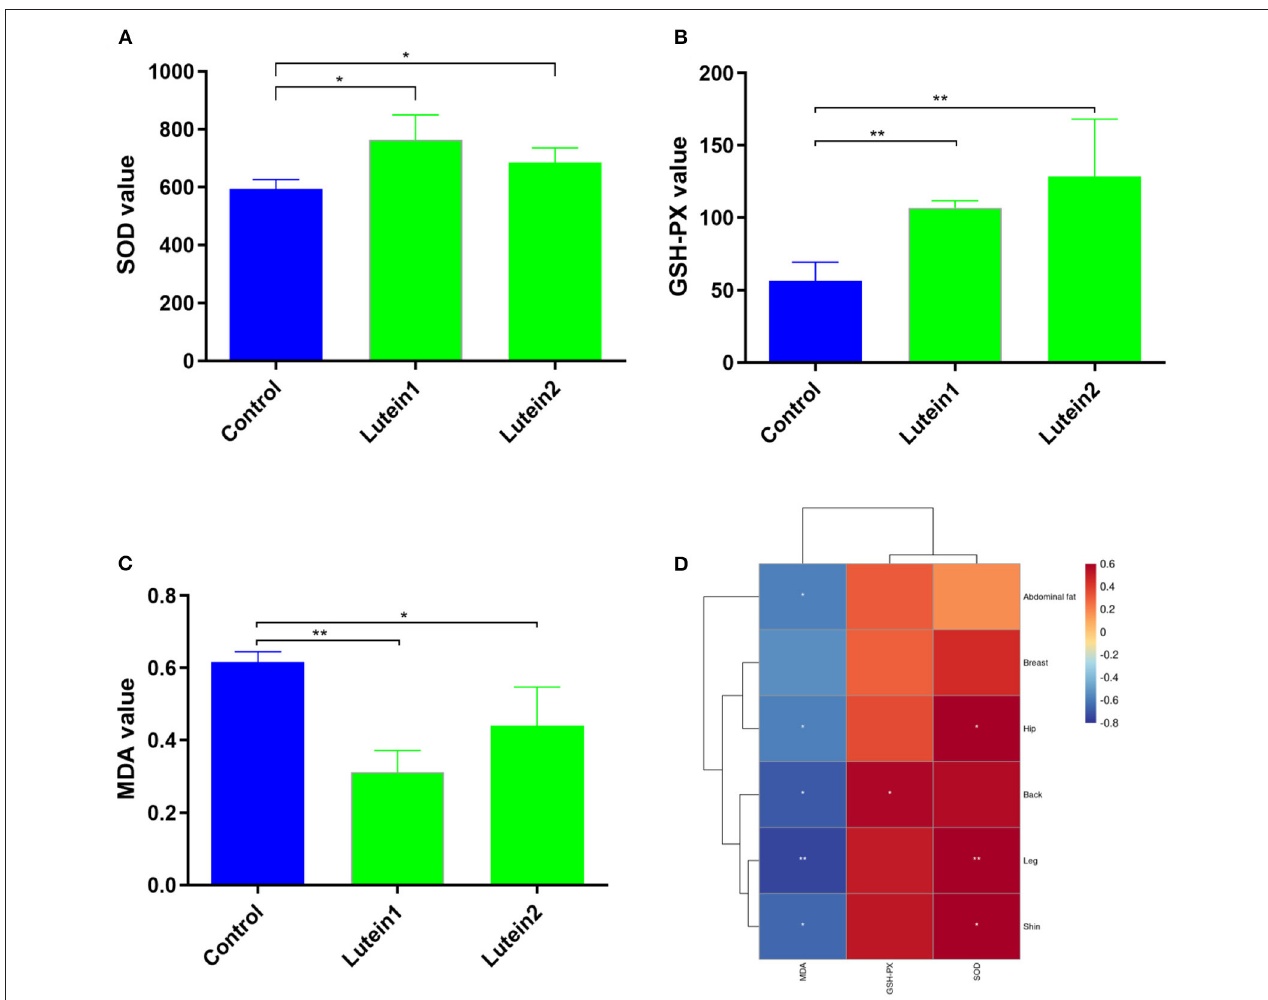
FIGURE 2 | Determination of the liver antioxidant index. (A) SOD value of the liver. (B) GSH-PX value of the liver. (C) MDA value of the liver. (D) Correlation between skin yellowness and antioxidant indices. The color from blue to red indicates a negative correlation to a positive correlation, * P < 0.05; ** P <